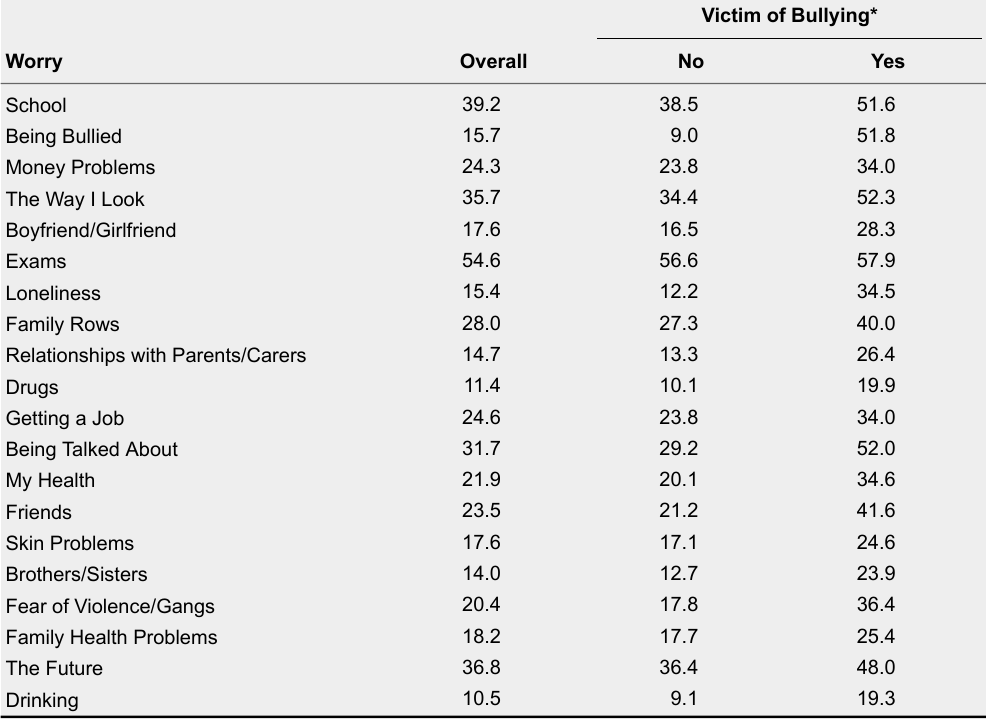
Percentage of ‘Yes’ Reports for Each Type of Worry, Overall and By Victim Status